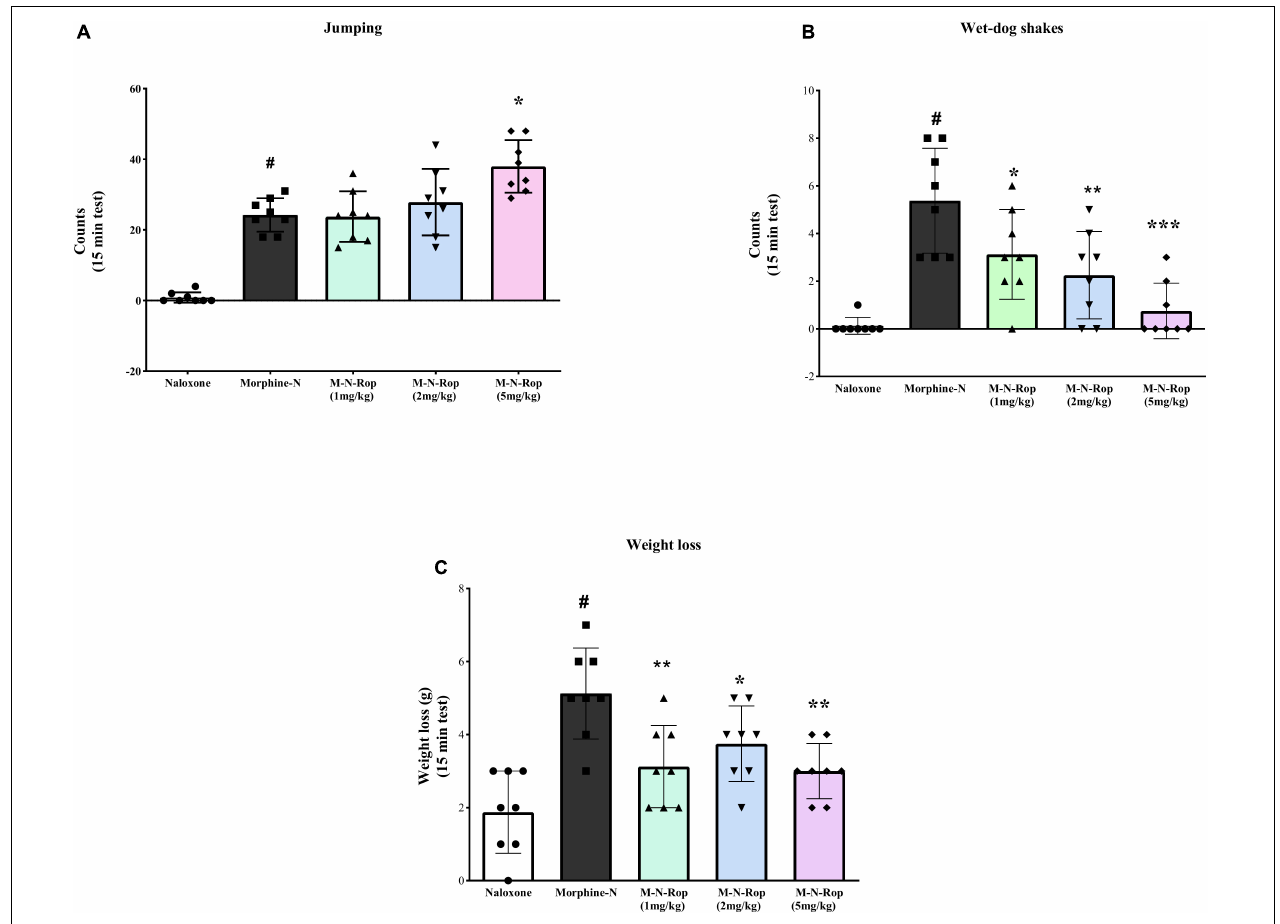
FIGURE 6 | The effect of ropinirole on morphine withdrawal syndrome. Results represent mean ± SD , one-way ANOVA post hoc Dunnett’s test ( n = 8). (A) jumping count; # p < 0.001 compared with naloxone group and * p < 0.01 compared with the morphine-naloxone (Morphine-N) group. (B) wet-dog shakes count; # p < 0.001 compared with naloxone group and * p < 0.05, ** p < 0.01, *** p < 0.001 compared with the morphine-naloxone (Morphine-N) group. (C) weight loss; # p < 0.001 compared with naloxone group and * p < 0.05, ** p < 0.01, ** p < 0.01 compared with the morphine-naloxone (Morphine-N) group. Morphine-M, Naloxone-N,